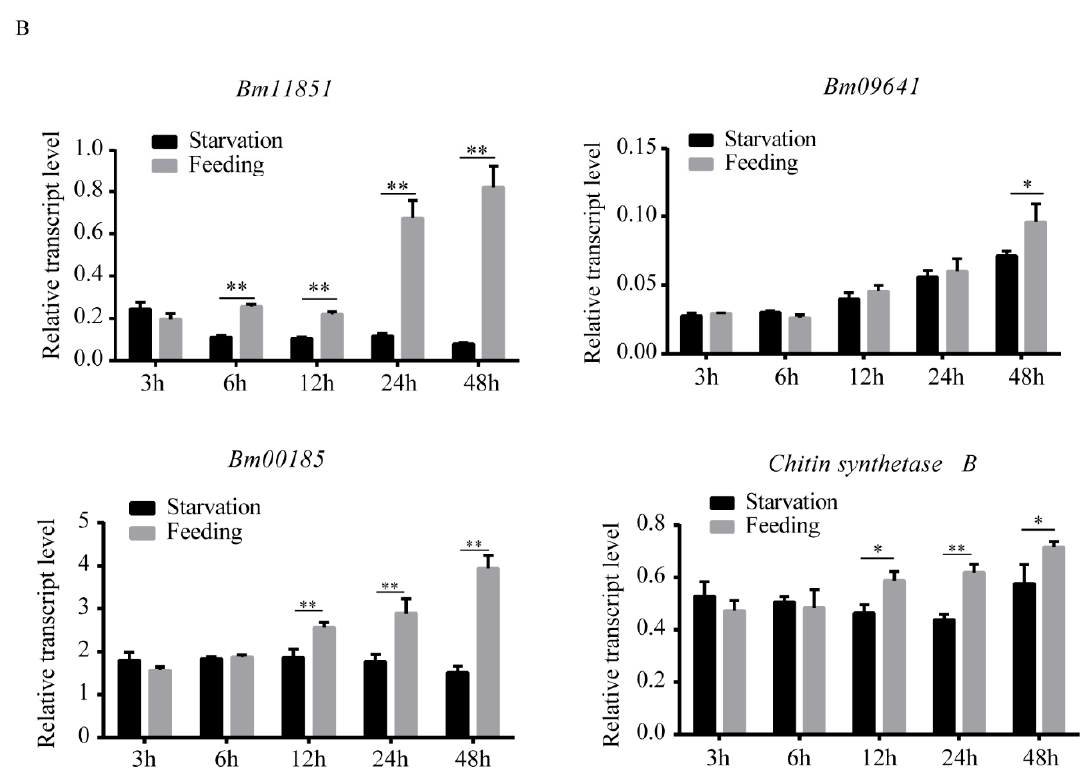
Figure 3. Restoration of the peritrophic matrix (PM) structure may be promoted by food ingestion. ( A ) Morphological changes of the lumen side of the PM in silkworm larvae were observed at different times during starvation and feeding using scanning electron microscopy (3000 × ). 5L0d, day 0 of the fifth instar. ( B ) Expression of four genes encoding components of the PM in silkworm on day 0 of the fifth instar larvae at different times post-initiation of starvation and feeding. * p < 0.05, ** p <